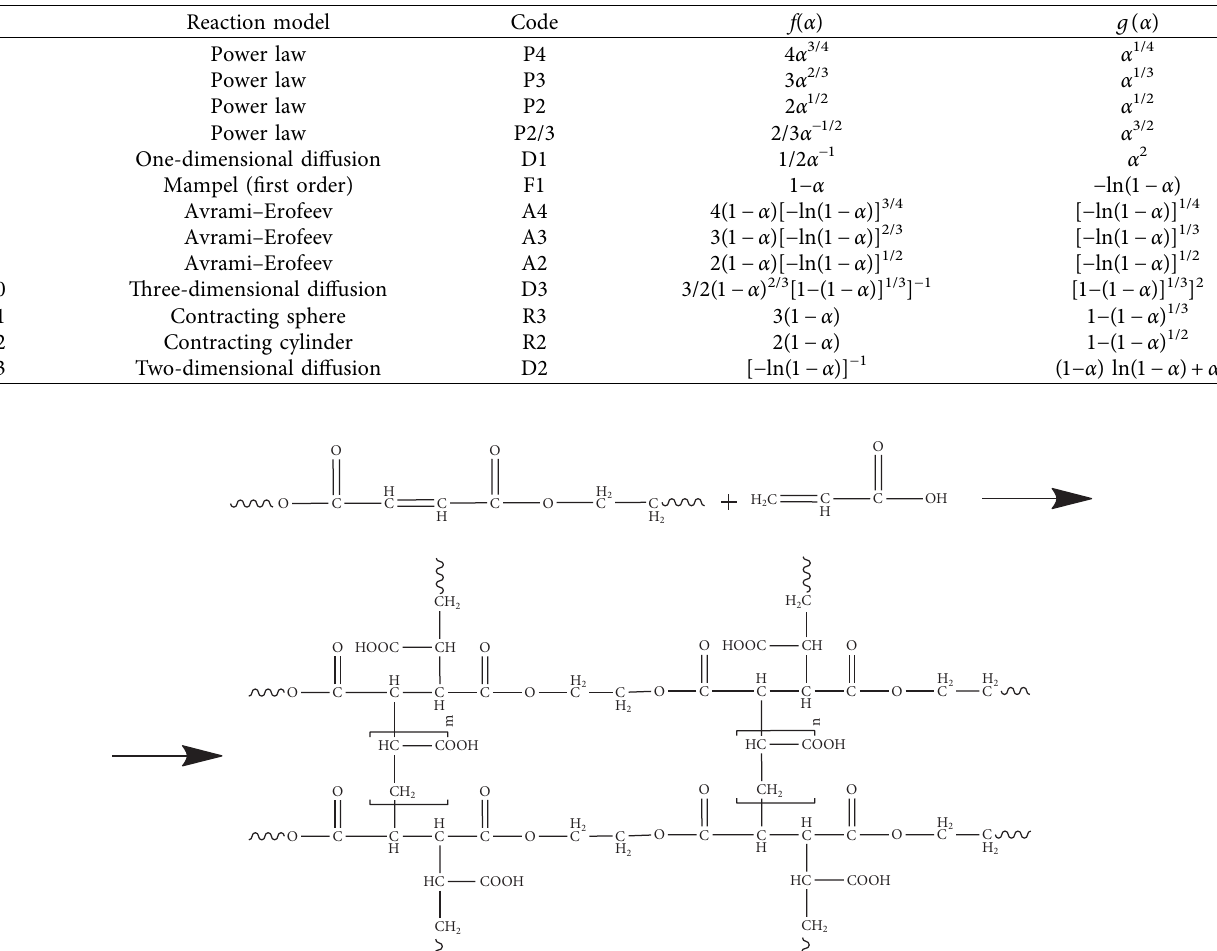
Table 1: Some of the kinetic models used in the solid-state kinetics.